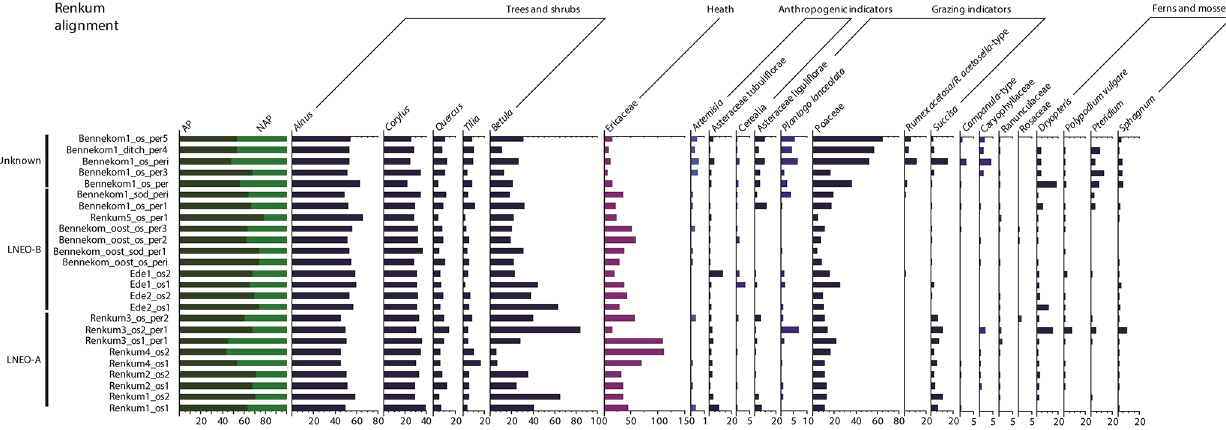
Figure 4. Pollen spectra from the samples taken from the barrows of the Renkum